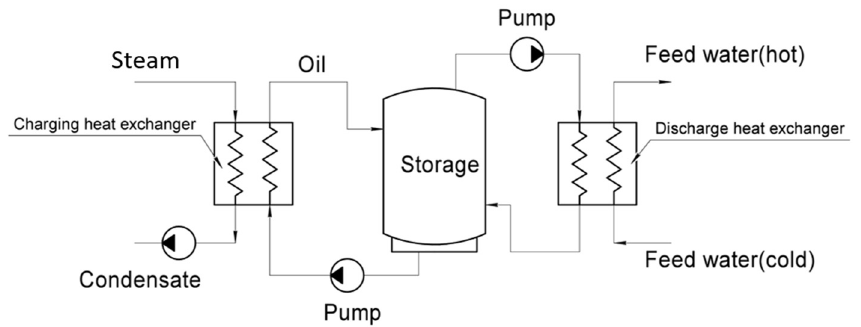
Figure 13. Heat flow chart with an intermediate heat carrier.